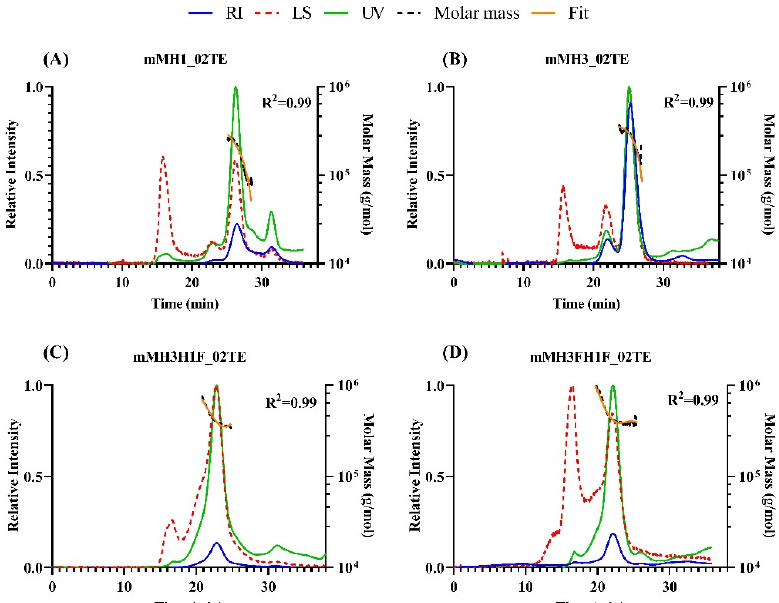
Figure 3. SEC-MALS profile of purified hemagglutinin immunogens. Relative intensities of all traces [UV (green), refractive index (blue), and light scattering (red)] are plotted as a function of elution time. Orange trace and black trace representing the fit and molar mass for trimeric fractions of HA immunogens are shown. ( A ) mMH1_02TE, ( B ) mMH3_02TE, ( C ) mMH3H1F_02TE, ( D ) mMH3FH1F_02TE.